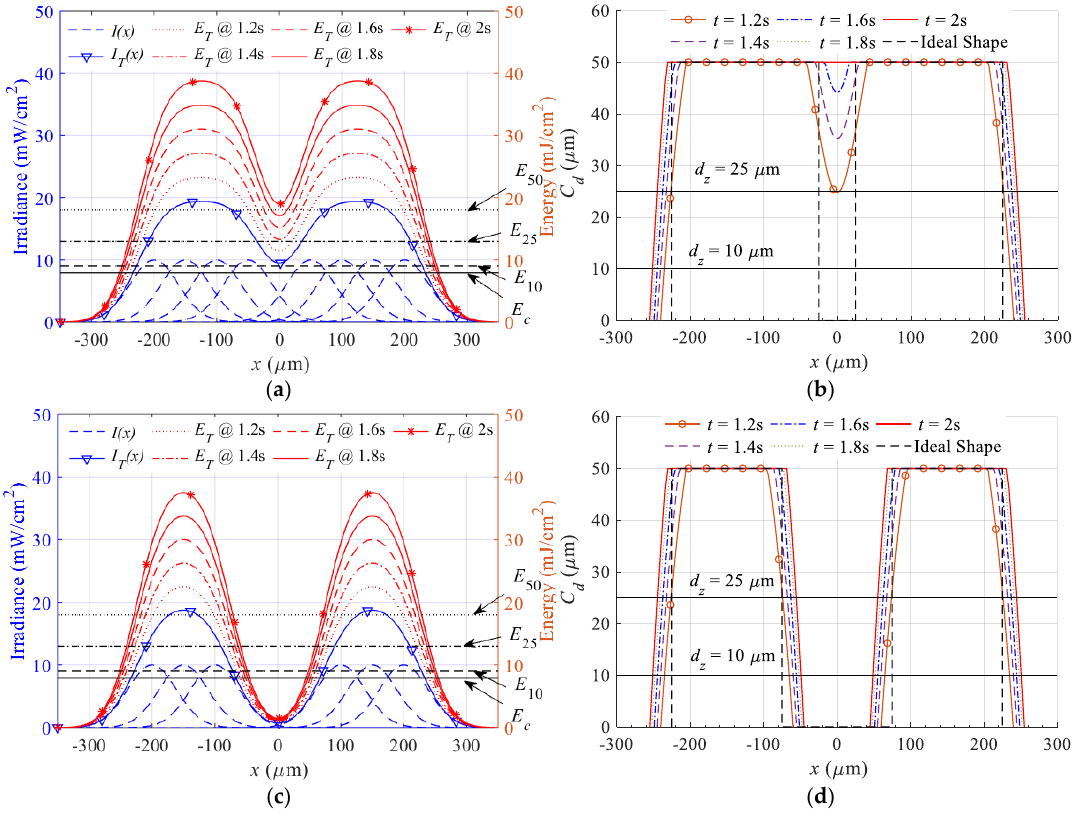
Figure 3. Effect of exposure time, while with one micromirror turned off, on ( a ) superposition energy Figure 3. E ff ect of exposure time, while with one micromirror turned o ff , on ( a ) superposition energy ( b ) lateral dimensions, and effect of exposure time, while with three micromirrors turned off, on ( c ) ( b ) lateral dimensions, and e ff ect of exposure time, while with three micromirrors turned o ff , on ( c ) superposition energy ( d ) lateral dimensions. superposition energy ( d ) lateral